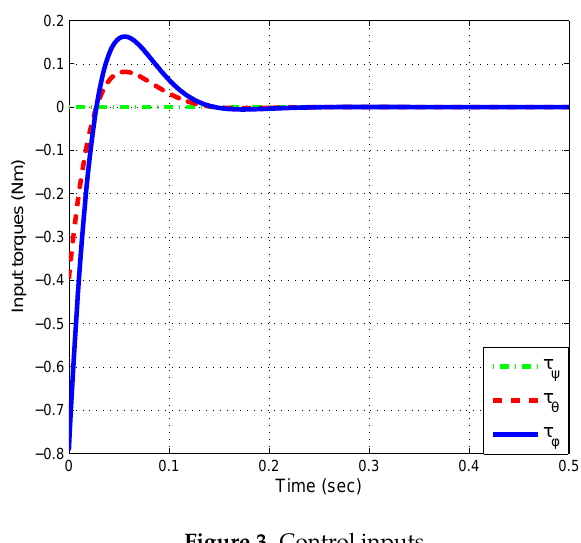
Figure 3. Control